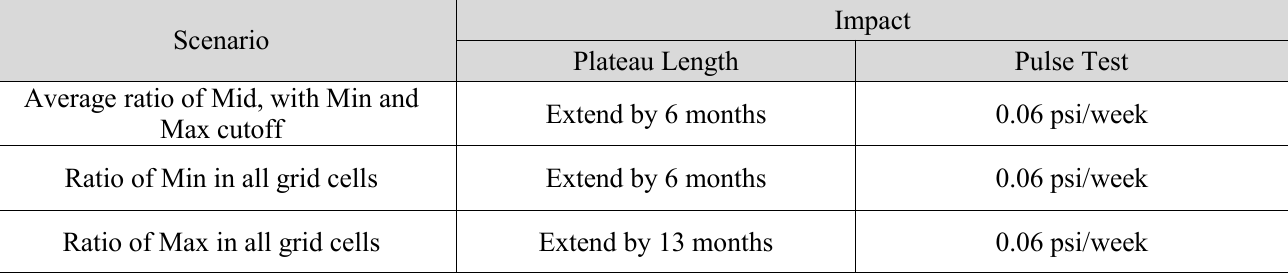
Figure 16—Production Profiles Generated from Min, Mid and Max Case Fracture Models. Table 1— k maxfx / k minfx Ratio Sensitivity